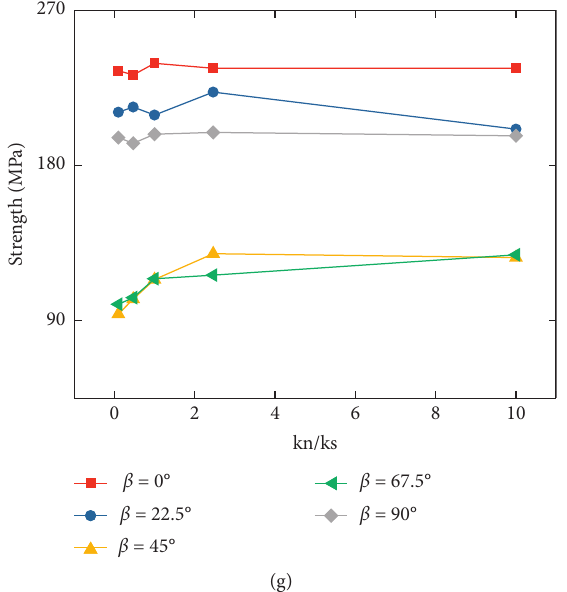
Figure 11: The cumulative distribution curve and average fragment size of layered rocks with different bedding stiffness. (a–e) The distribution curve of 0 ° , 22.5 ° , 45 ° , 67.5 ° , and 90 ° samples, red: ks/kn � 10, blue: ks/kn � 2.46, yellow: kn/ks � 1, green: kn/ks � 2.46, and gray: kn/ks � 10. (f) Average fragment size vs. bedding stiffness under different bedding angles. (g) Dynamic strength vs. bedding stiffness under different bedding